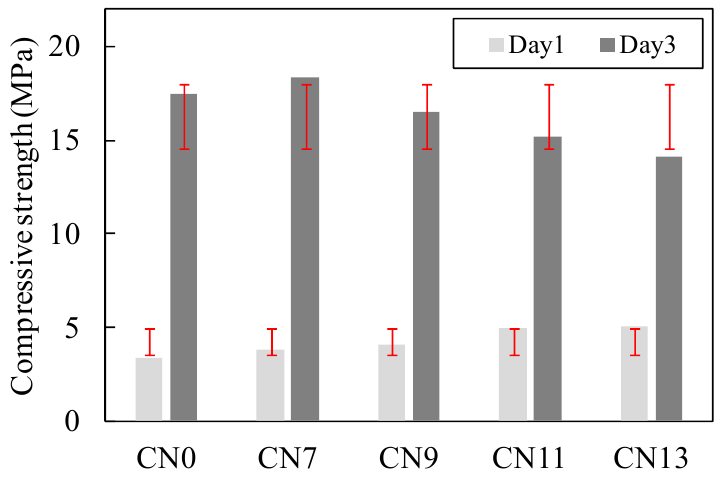
Figure 5. Compressive strength on Days 1 and 3.